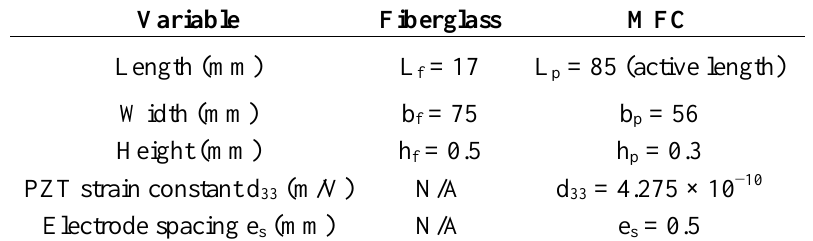
Figure 1. Geometry of a piezoelectric (PZT) bimorph actuator. Table 1. Characteristics of the PZT bimorph actuator. MFC, macro-fiber